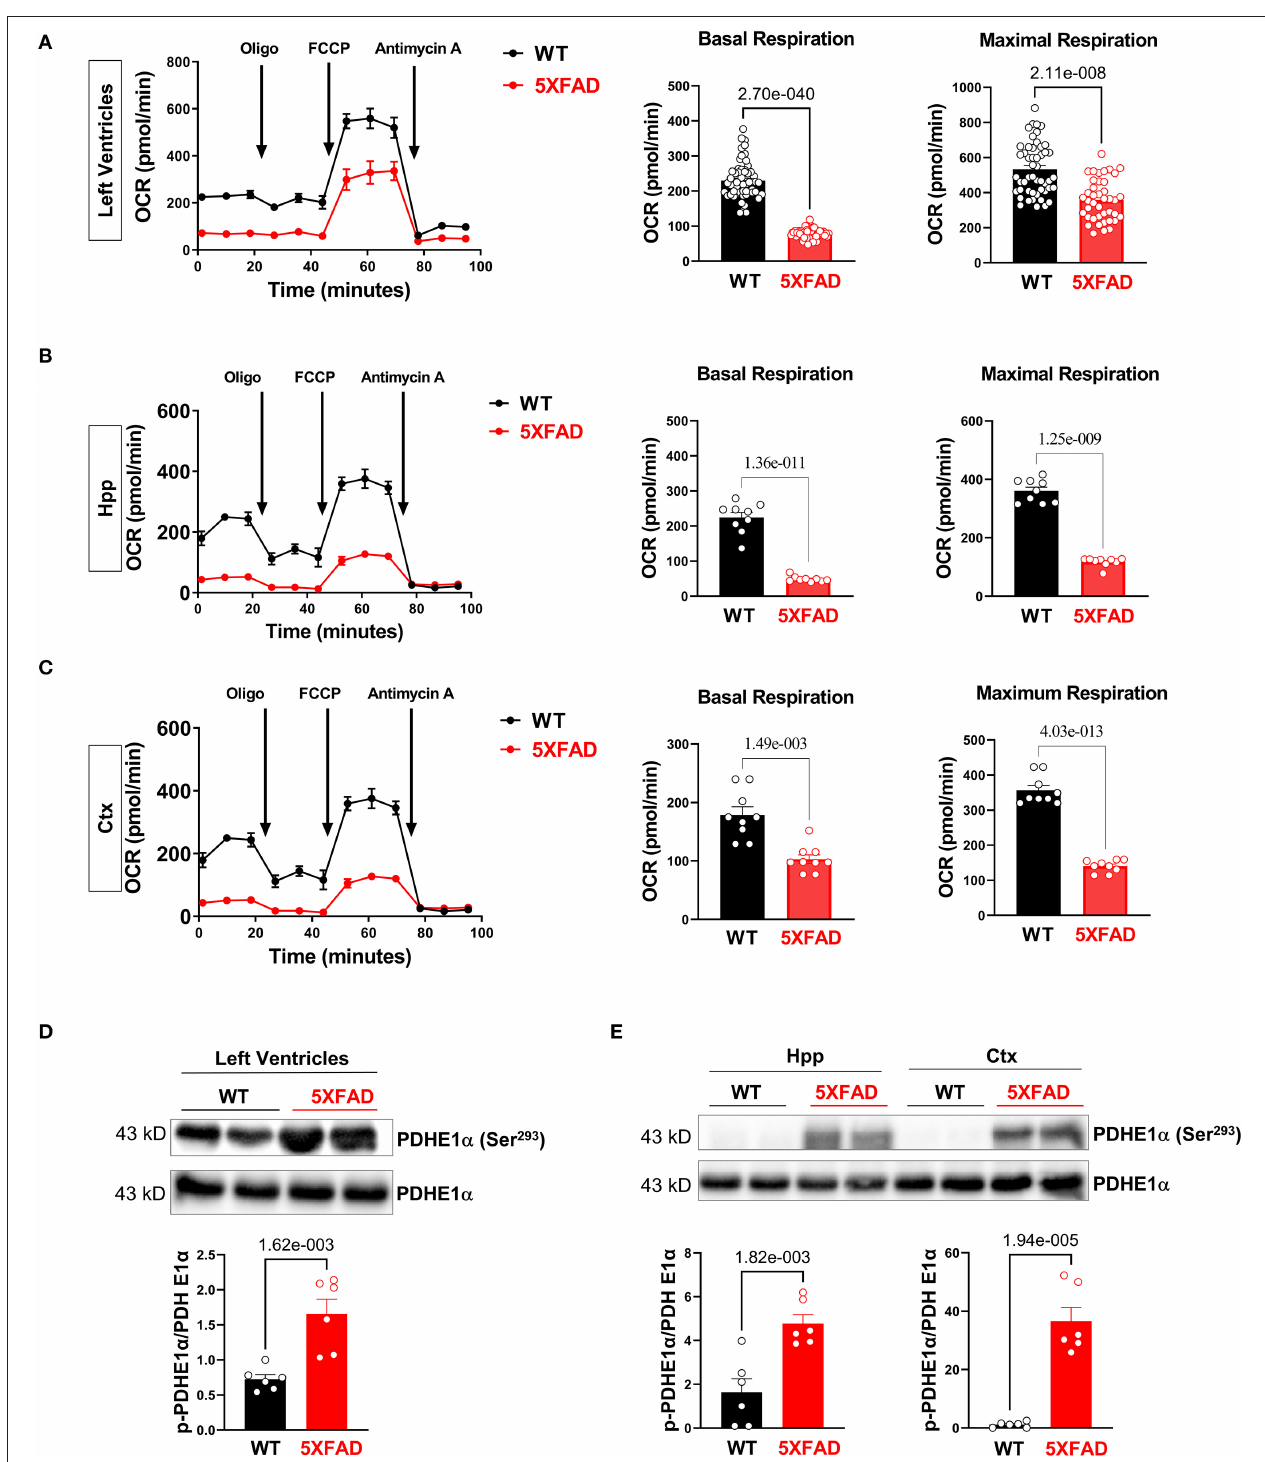
FIGURE 3 | Impairs mitochondrial oxidative phosphorylation in the 5XFAD heart, hippocampus, and cortex. (A) Mitochondrial stress assay examined the mitochondrial oxidative phosphorylation (OXPHOS) complexes activity in the heart of 5XFAD (6 months) and WT (6 months) mice demonstrated by measuring the oxygen consumption rate (OCR). N = 6 for each group. P -value determined by two-tailed students t -test. (B) Mitochondrial stress assay examined the mitochondrial